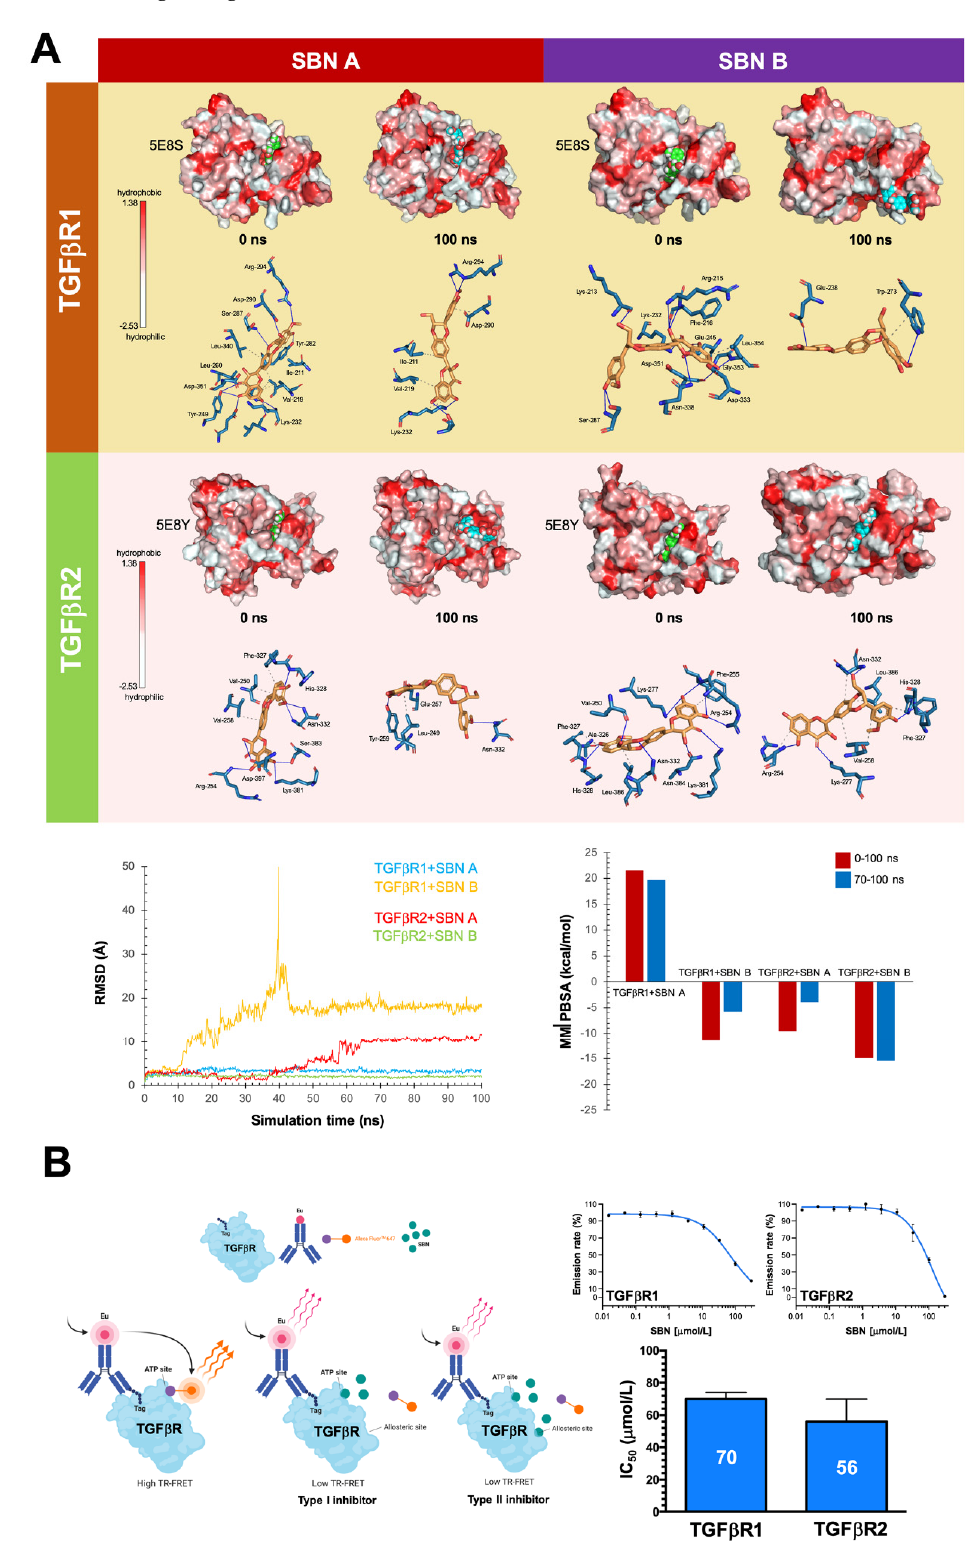
Figure 4. In silico prediction and in vitro verification of silibinin as a weak, direct inhibitor of TGF β Rs 1 and 2. ( A ) Top: The best poses of silibinin A and silibinin B coupled to the catalytic site of TGF β R1 (5E8S) and TGF β R2 (5E8Y) before (0 ns) and after (100 ns) the molecular dynamics (MD)